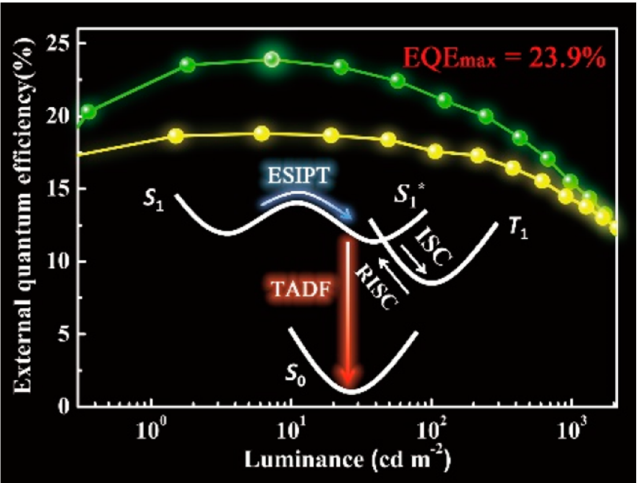
Figure 5. Efficiency scheme. TADF (thermally activated delayed fluorescence, ISC, intersection crossing). Yellow data are for PXZDO. Taken from Ref. [77] with permission from the American Chemical Society.